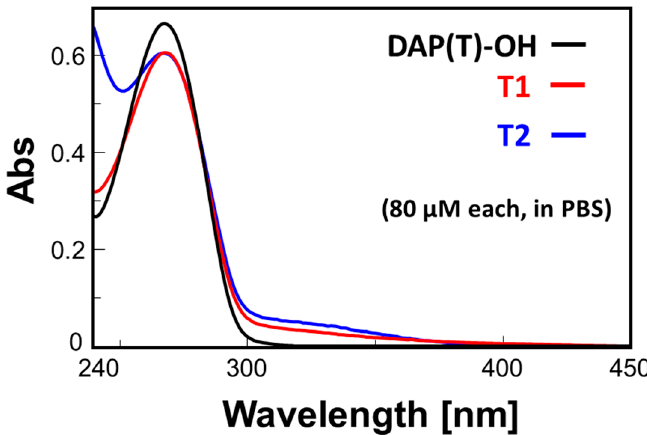
Figure 2. Overlapped ultraviolet-visible (UV-vis) spectra of the two platinum complexes ( T1 and T2 ) and the starting ligand DAP(T)–OH dissolved at 80 μ M concentration in phosphate-buffered saline (PBS).